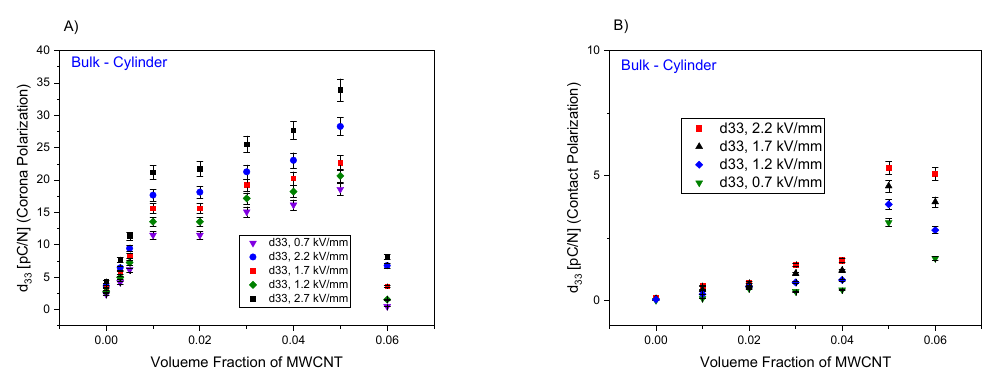
Figure 1. Variation in the piezoelectric strain coe ffi cient, d 33 for bulk PZT-epoxy-multi-walled carbon nanotube (MWCNT) composites as a function of polarization voltage from 0.7–2.7 kV / mm; for ( A ) corona poling and ( B ) contact poling methods. Both the figures show an increase in d 33 with an increase in the poling voltage.